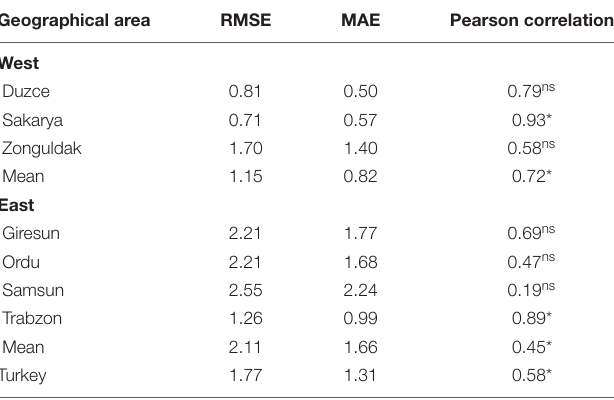
TABLE 4 | Model performances in reproducing rotten incidence in